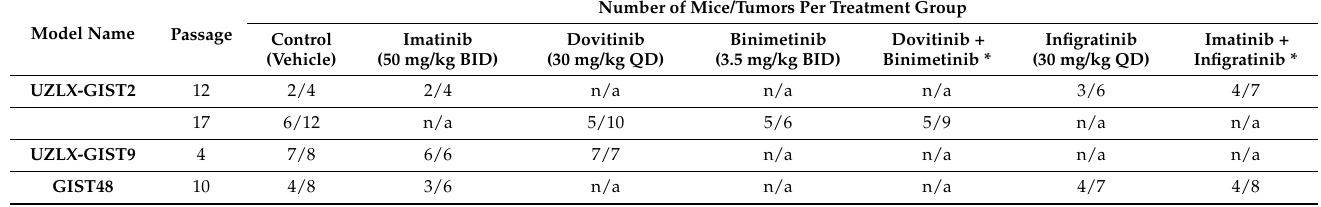
Table 2. Experimental set-up including model/passage used, treatment dose, and schedule. The number of mice represents animals that entered the experiment, the number of tumors denote samples taken into the account for the final